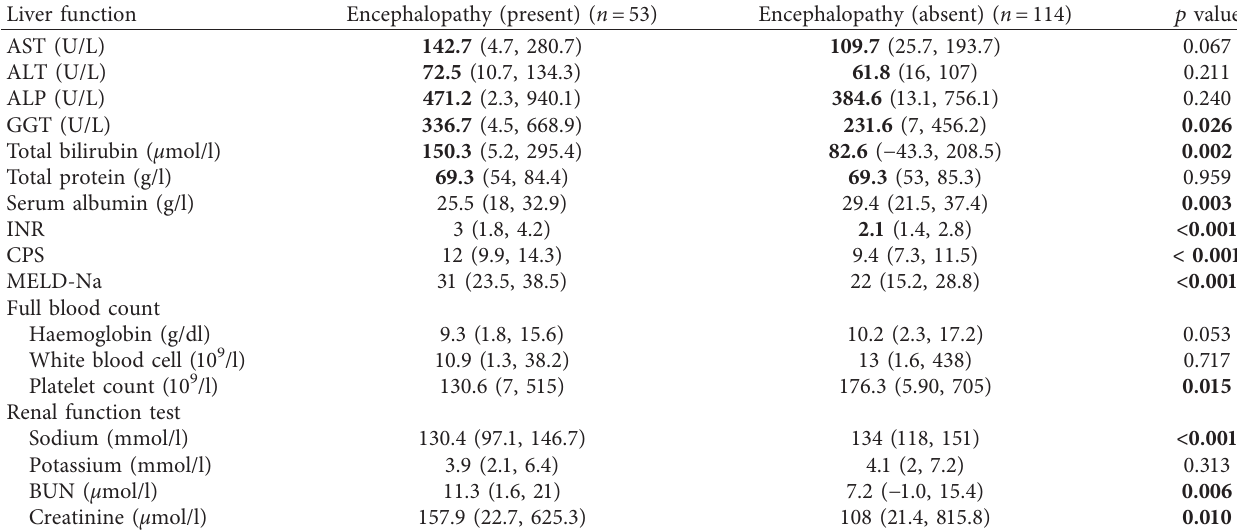
Table 6: Laboratory parameters of the study participants.